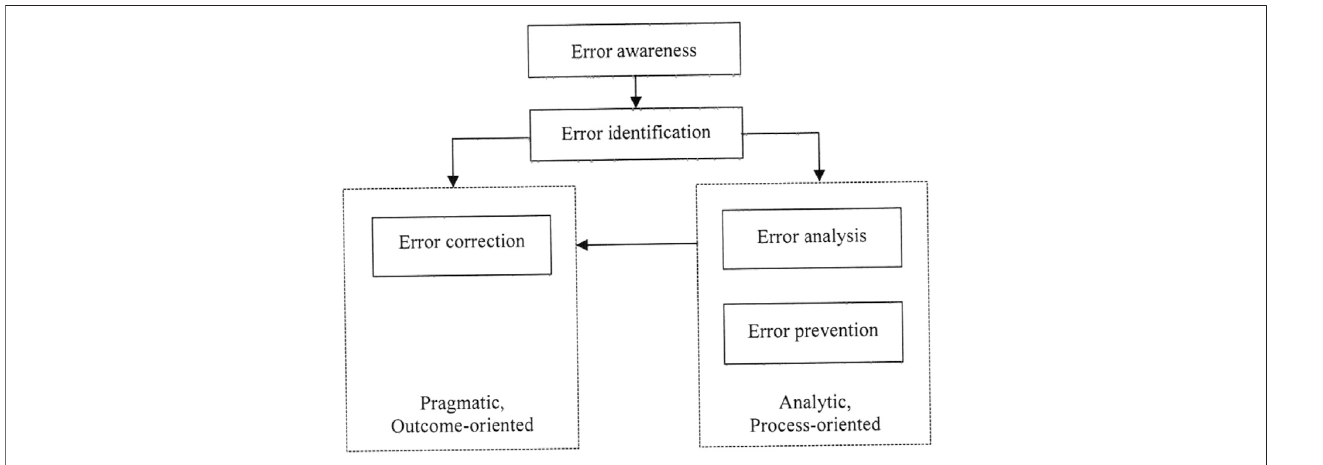
FIGURE 1 | The model for learning from errors [adapted from Rach et al. (2012), p.